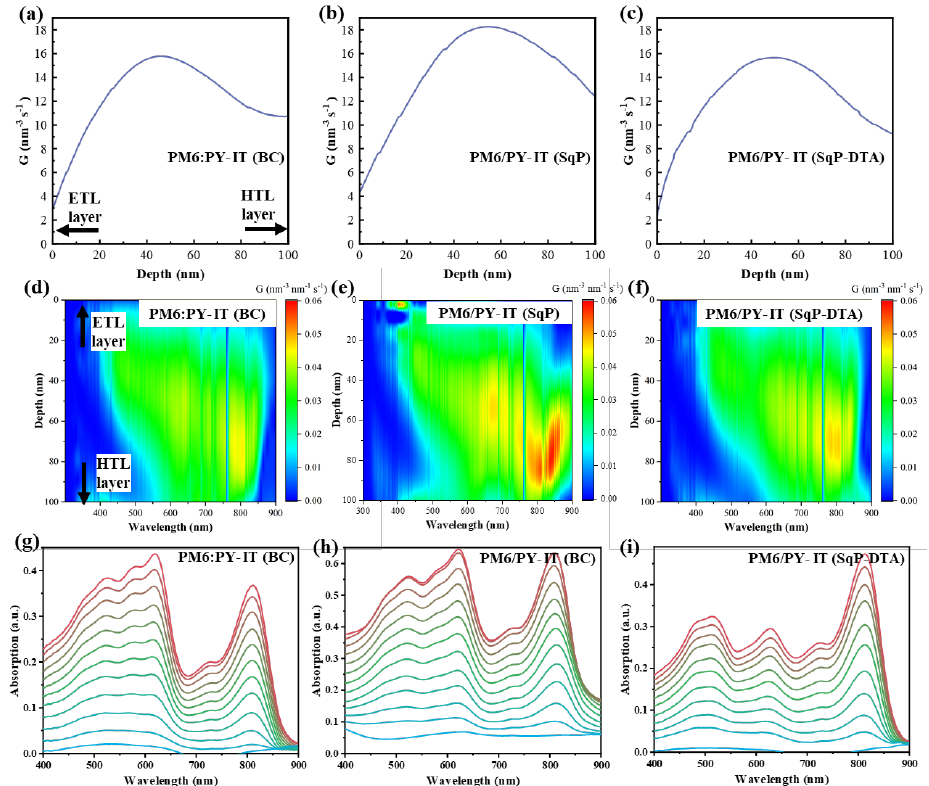
Figure 5. ( a – c ) Integrated generation rate in the vertical direction of the film. ( d – f ) Exciton generation map across the vertical direction of the active layer film as a function of wavelength. ( g – i ) Film-depth-dependent light absorption spectra.